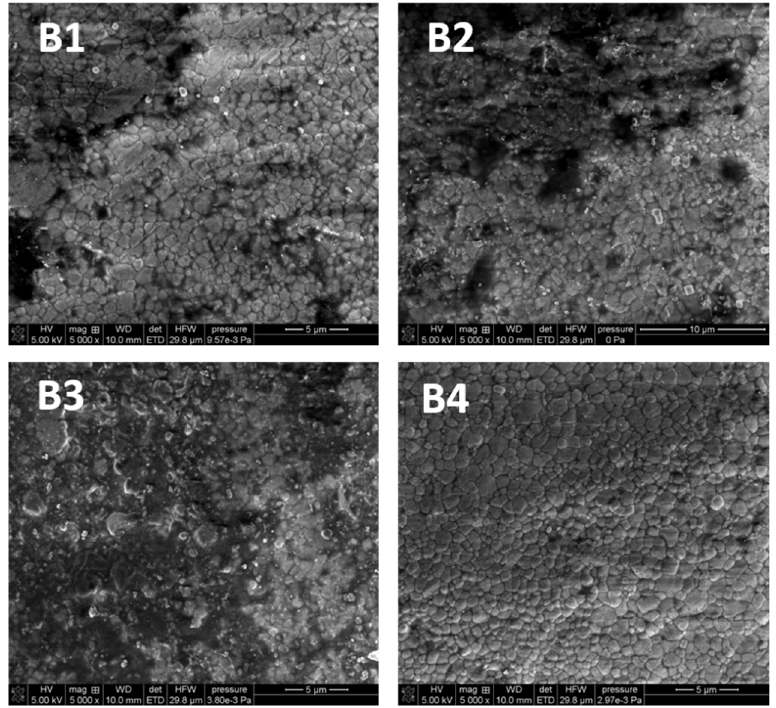
Figure 4. The SEM images of zirconia (5000×): ( B1 ) untreated control sample; ( B2 ) after irradiation with L1; ( B3 ) after irradiation with L2; ( B4 ) after irradiation with L3.